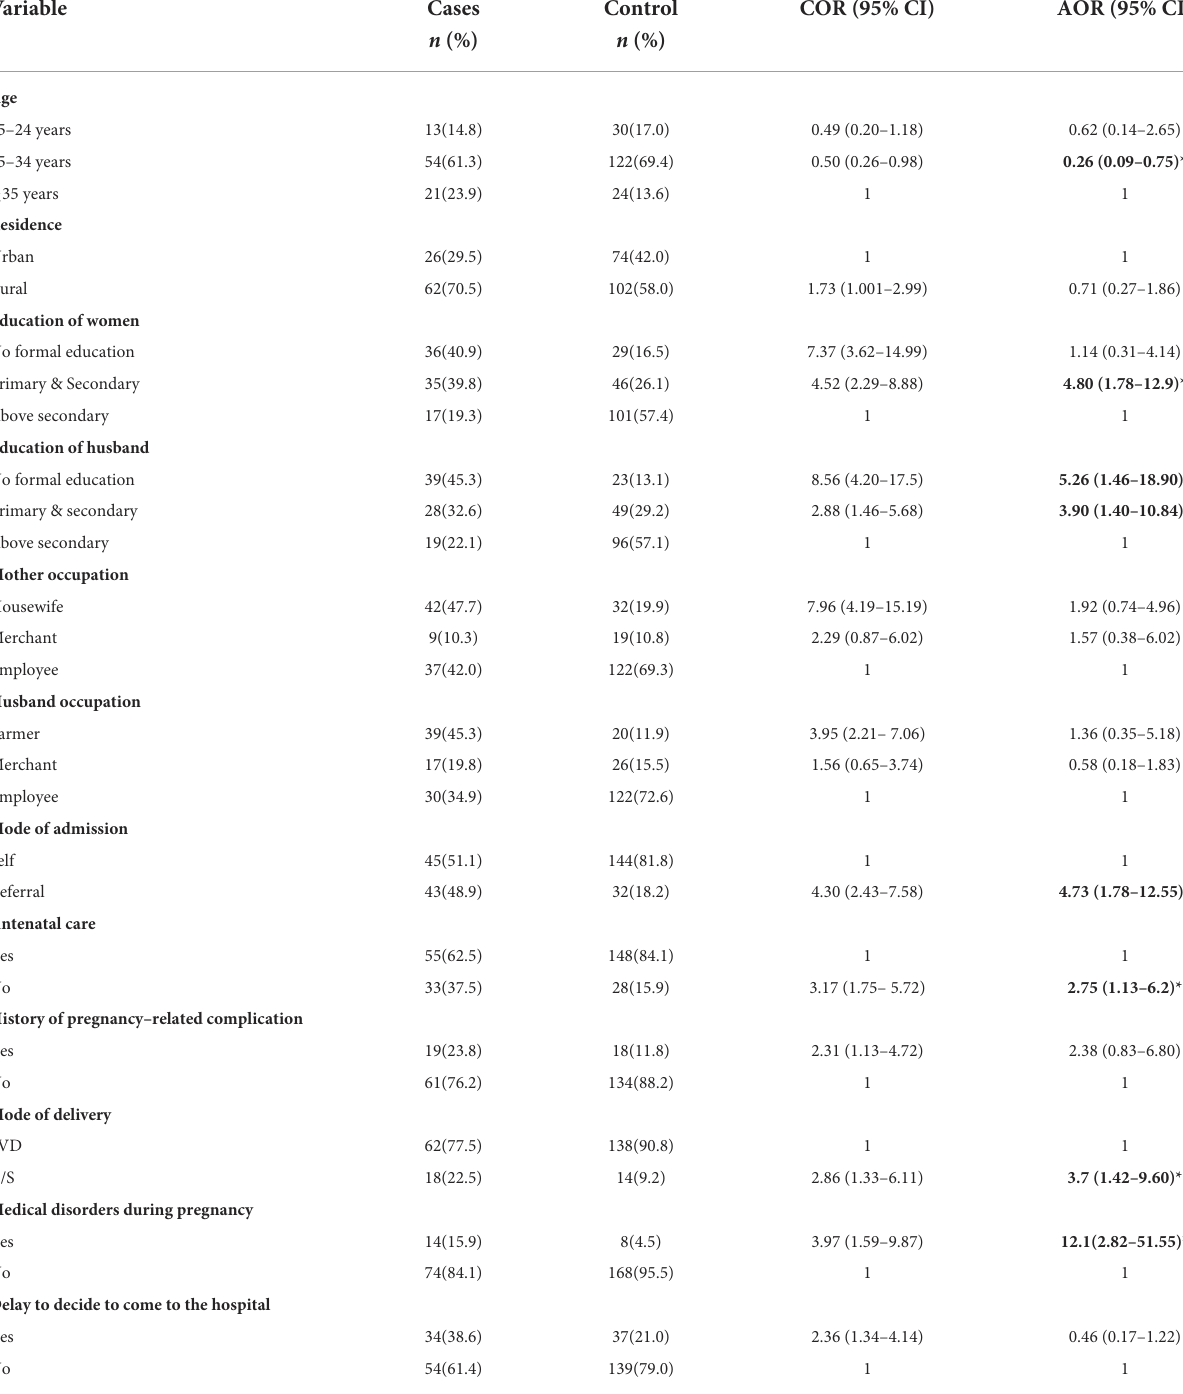
TABLE 5 Determinants of maternal near-miss in public hospitals, North Shewa Zone, Ethiopia, 2020 (N =